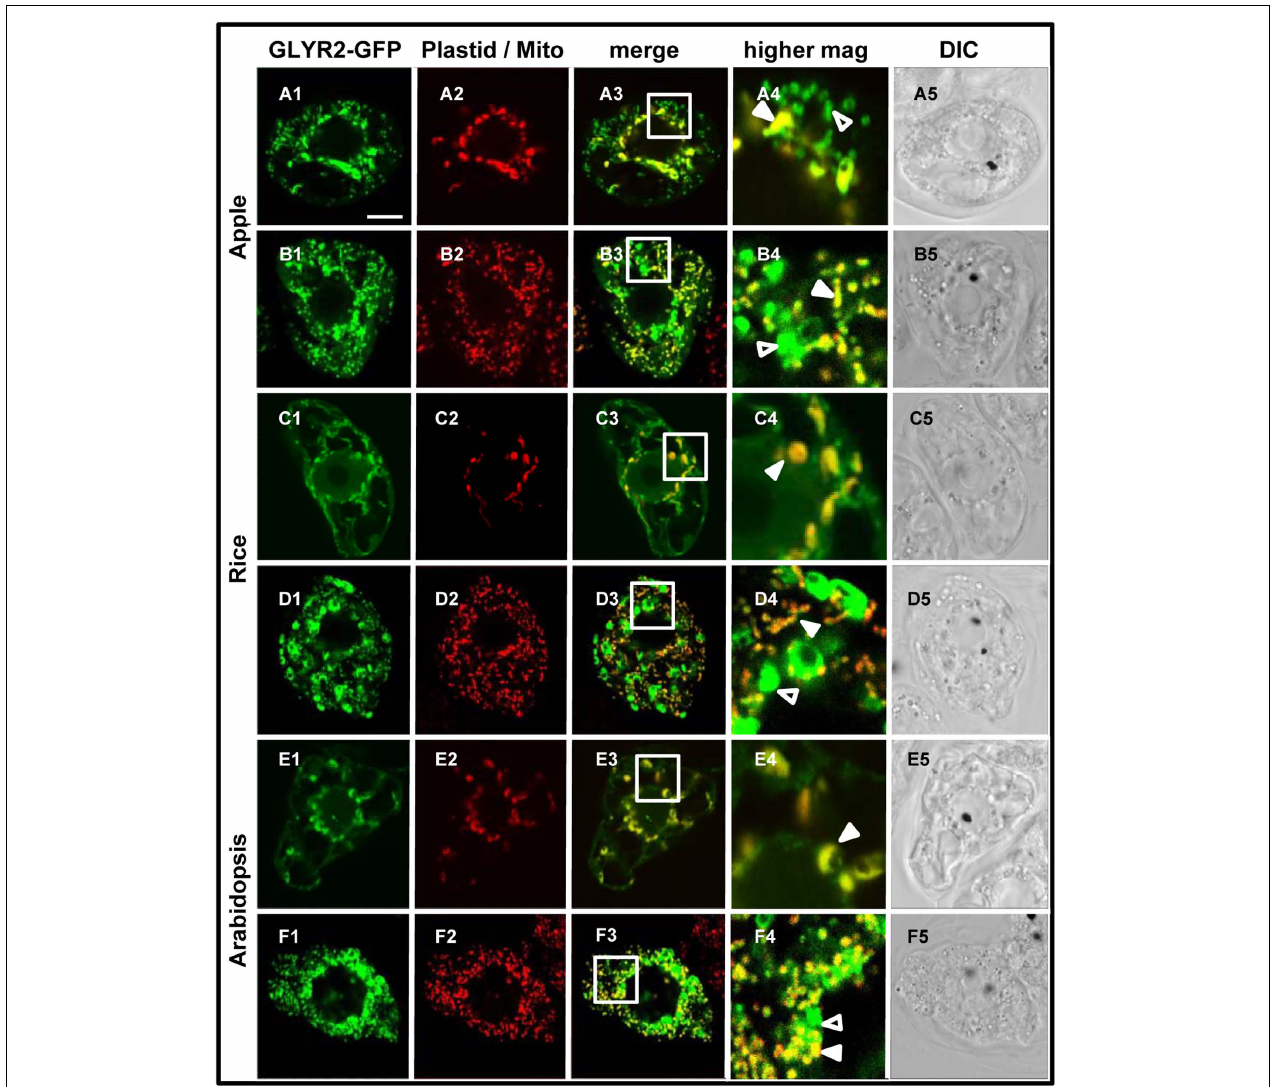
FIGURE 3 | Plastid and mitochondrial localization of Md GLYR2, At GLYR2, or Os GLYR2 in tobacco BY-2 cells. (A–F) Representative CLSM images of BY-2 cells (co)expressing (as indicated by the panel labels) Md GLYR2-GFP, Os GLYR2-GFP, or At GLYR2-GFP and either the plastid marker PDC pl -E2-Cherry or immunostained for endogenous, mitochondrial CoxII. Processing of cells for immunofluorescence and viewing using CLSM are described in the ‘Materials and Methods’. Shown also is the corresponding merged and DIC images for each cell. Boxes in the merged images represent the portion of the cell shown at higher magnification in the panel to the right. The yellow color in the merged images indicates co-localization; solid arrowheads indicate obvious examples of co-localization, whereas open arrowheads indicate obvious examples of non-co-localization. Scale bar in A = 10 µ